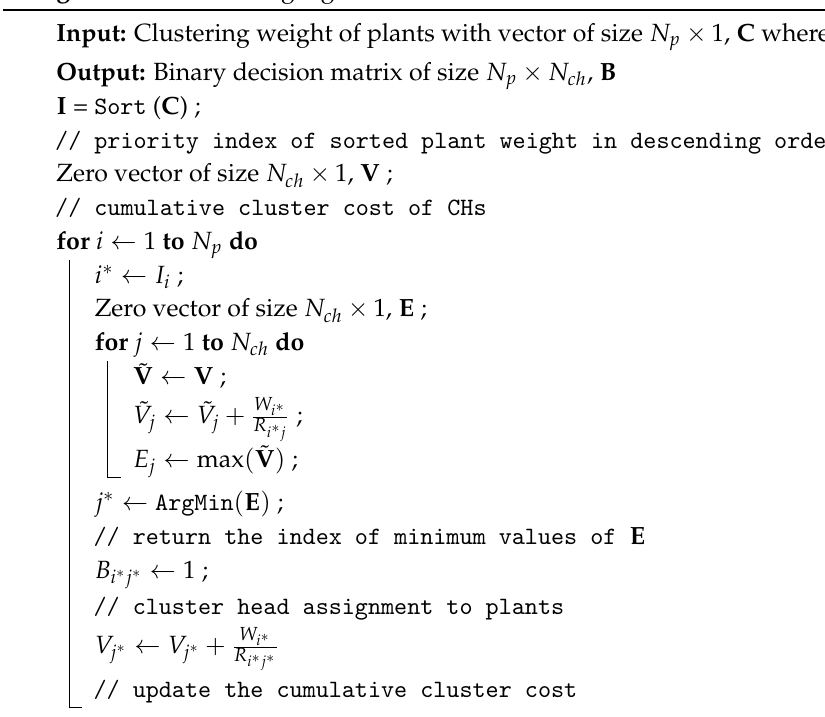
Algorithm 1: Clustering algorithm of GC.